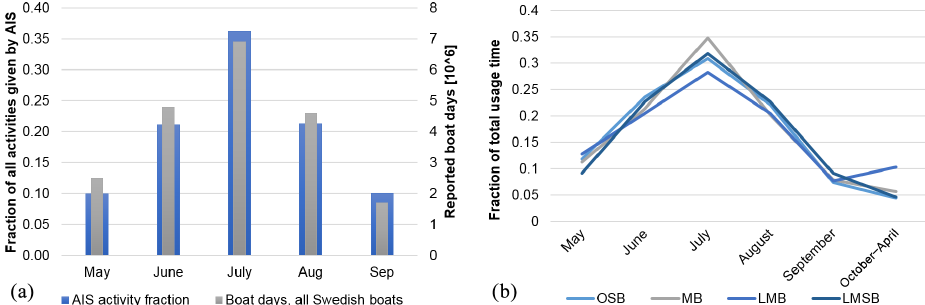
Figure 4. In (a) comparison of the temporal profile given by AIS versus reported boat days for all Swedish leisure boats in 2010. In (b) the reported temporal profiles for each leisure boat class separately are presented based on the reported boat days for all Swedish boats.